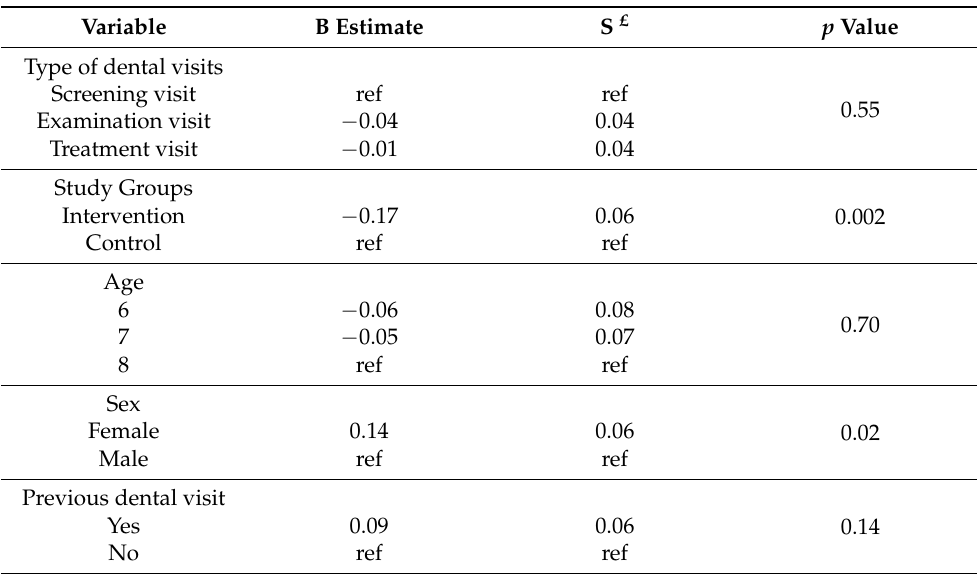
Table 4. Multivariate mixed-effects negative binomial regression model analysis for factors affecting the patient’s anxiety with